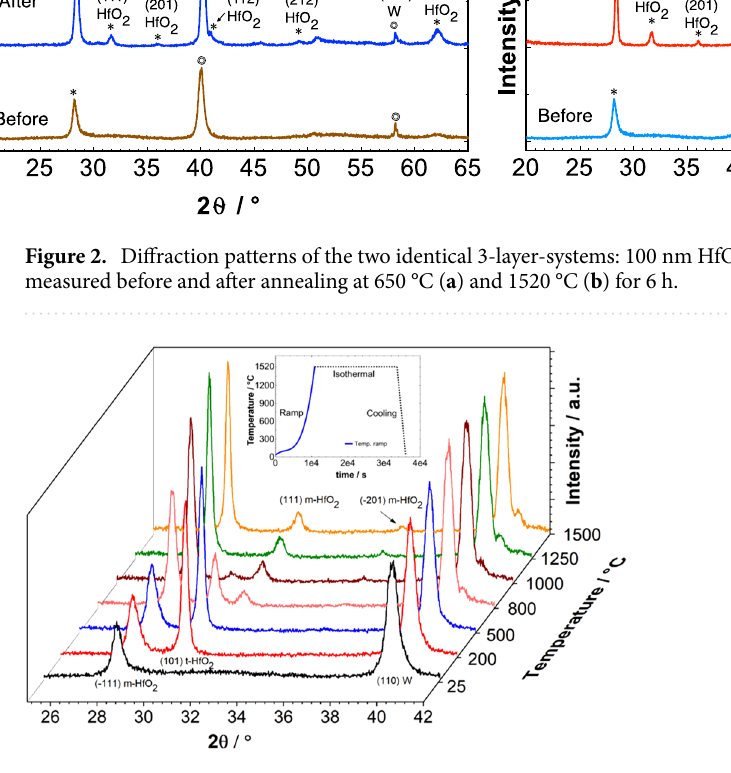
Figure 3. In-situ XRD 2θ scans of a 3-layer-system from room temperature until 1520 °C. During this temperature increase (represented by thick blue line in the inset, which shows the whole annealing experiment) a tetragonal phase of HfO 2 appears around 200 °C and later slowly disappears above 800